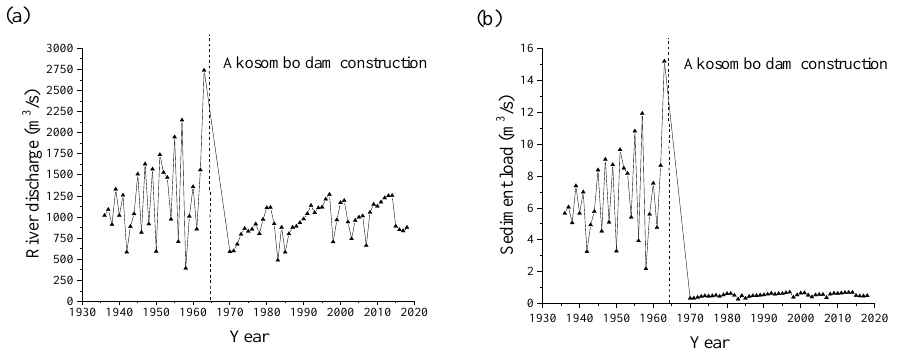
Figure 3. ( a ) Annual river discharge and ( b ) annual sediment load of the Volta River before and after Akosombo Dam construction.